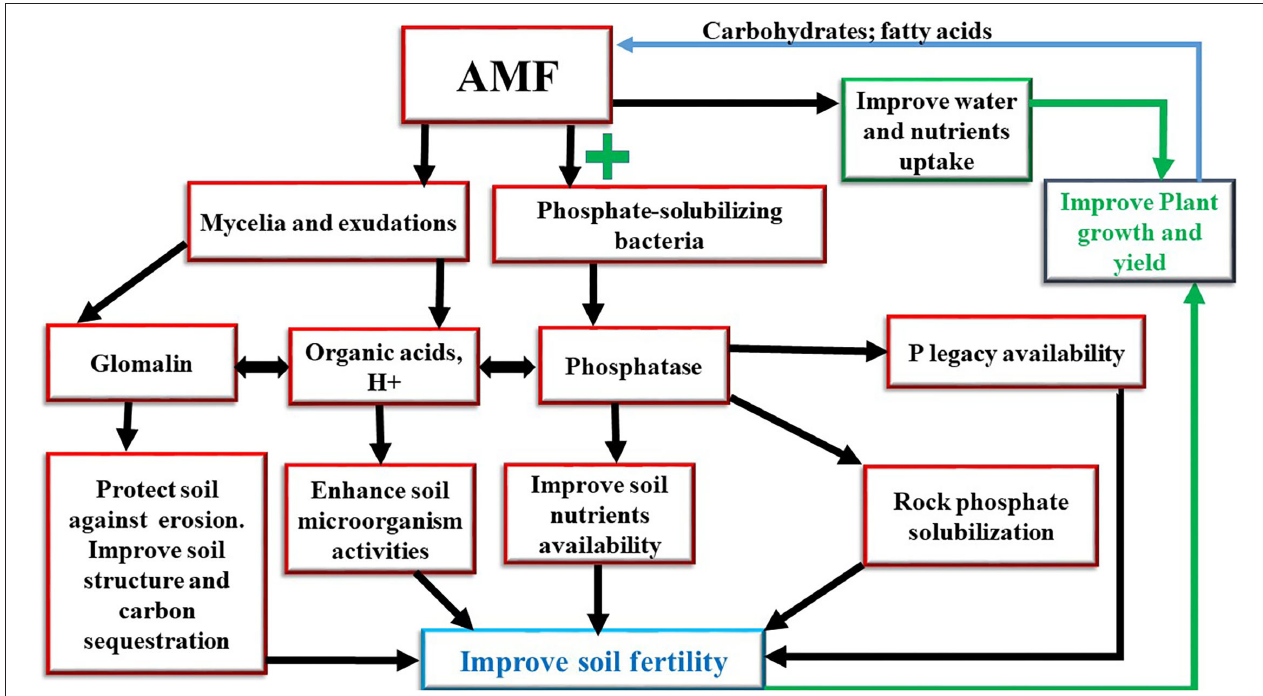
FIGURE 1 | Effects of arbuscular mycorrhizal fungi on improving soil